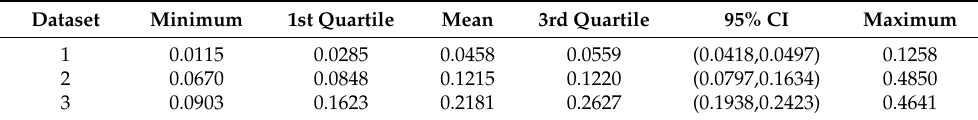
Table 9. Descriptive statistics of the three datasets.